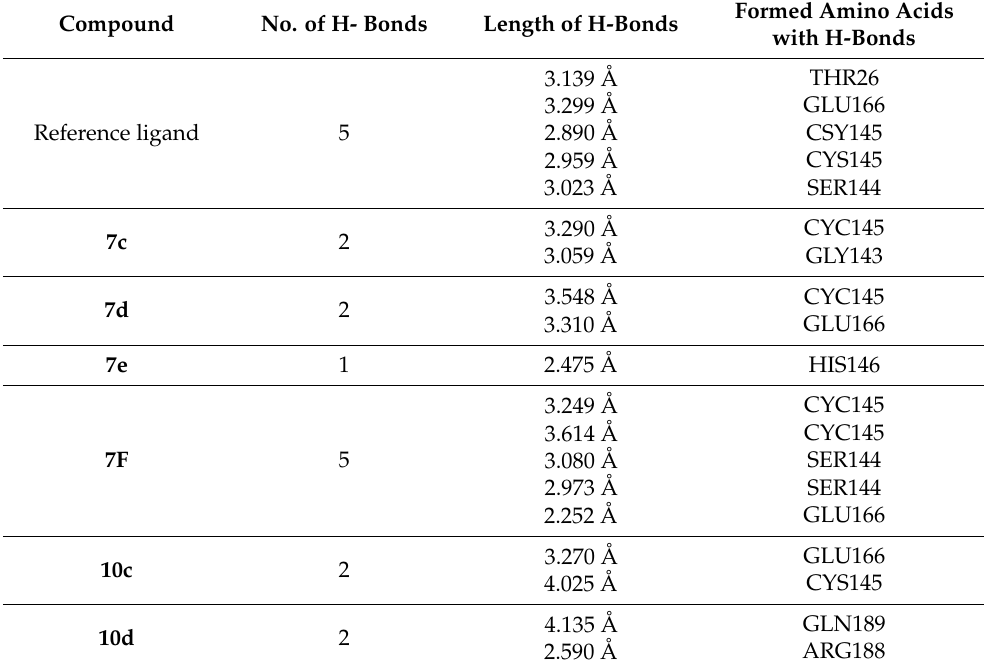
Table 3. The results of Hydrogen bond interaction of tested compounds against SARS-CoV-2 main protease “M pro ”. Compound No. of H- Bonds Length of H-Bonds